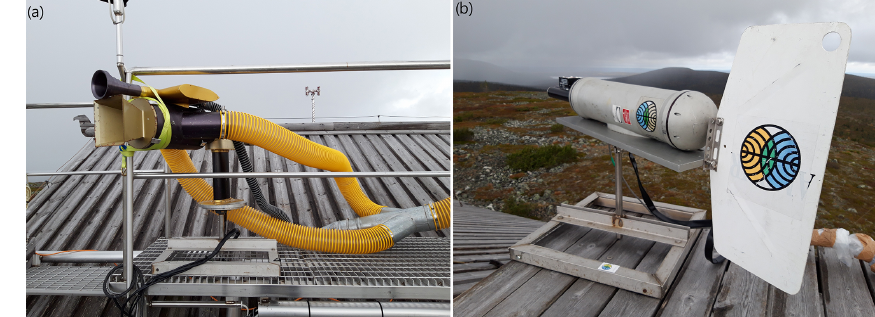
Figure 2. (a) CAPS and (b) FSSP-100 ground setups installed on the roof of Sammaltunturi station during PaCE